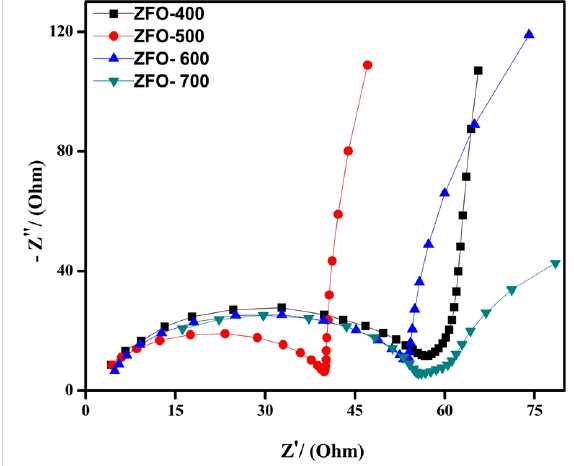
Figure 9: Nyquist plot of ZFO-400 to ZFO-700 photo anode in a fre- quency range from 50 to 10 5 Hz.